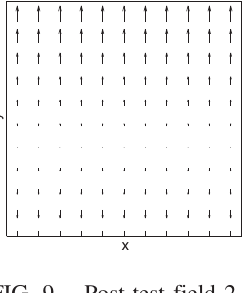
FIG. 9. Post-test field 2.